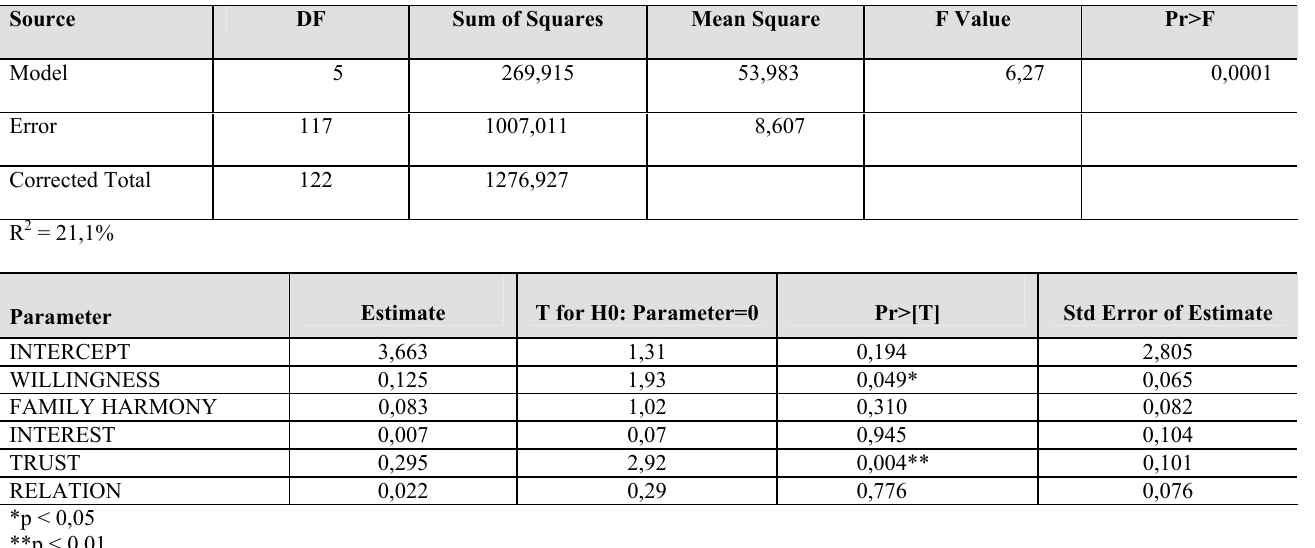
Table 2: Multiple regression results for owner-manager sub-sample: Satisfaction